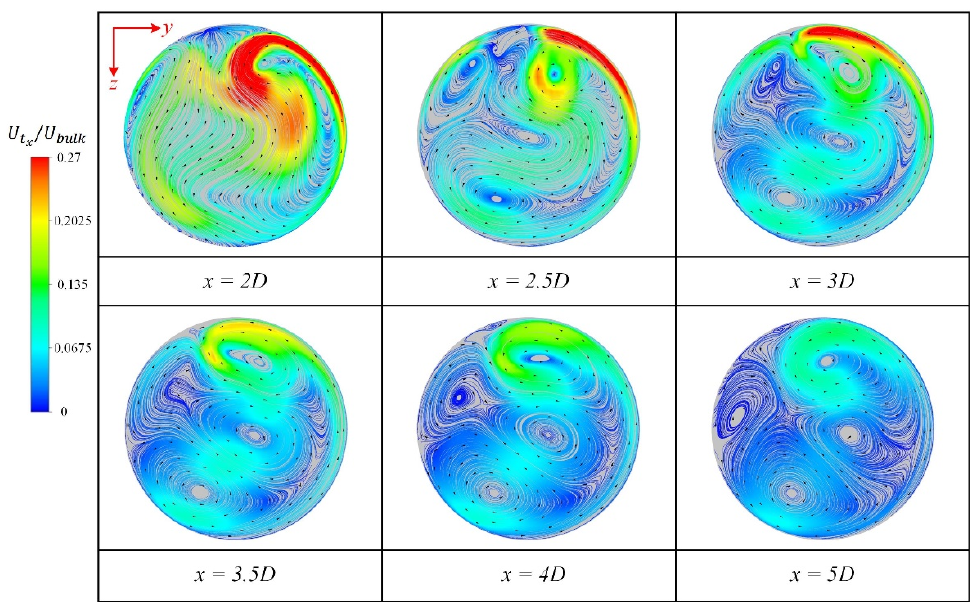
Figure 9. Streamlines and tangential velocity vectors downstream the second bend in Case-90°-3D.